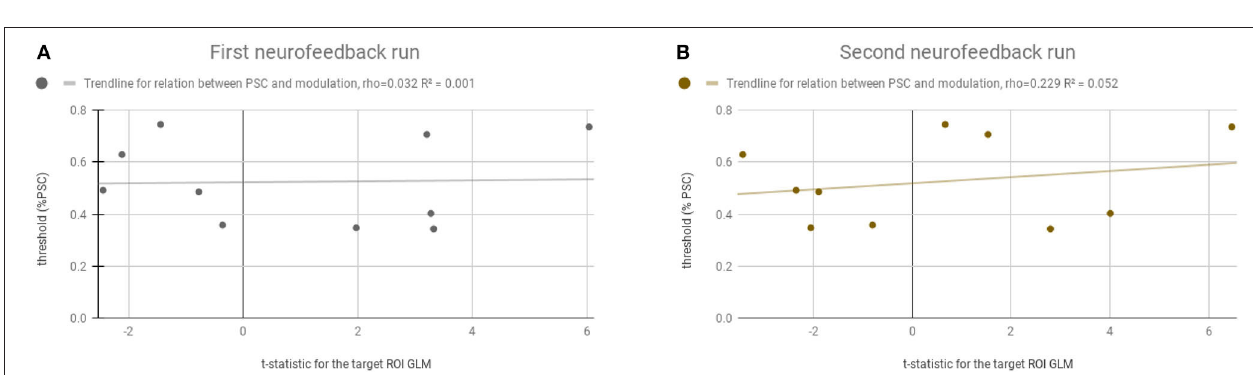
insula and basal ganglia in motivational processing, a key aspect of neurofeedback training. Ventral striatum is also part of the reward network, as reward-related activity in ventral striatum has been demonstrated in FitzGerald et al.